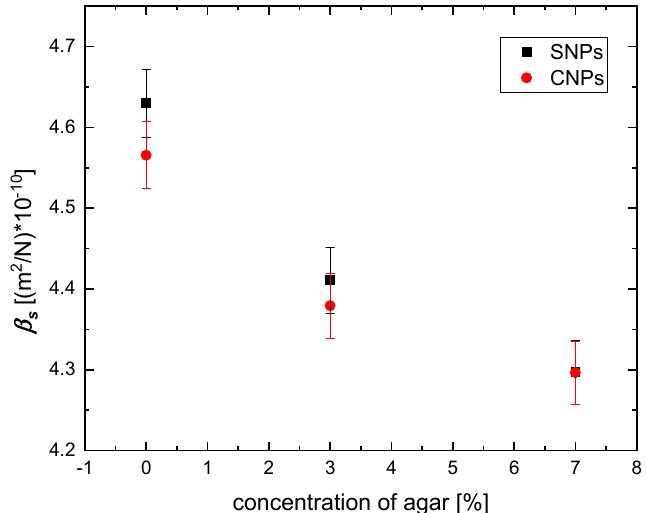
Figure 4. Compressibility of tissue-mimicking phantoms doped with SNPs or CNPs for different concentrations of agar.